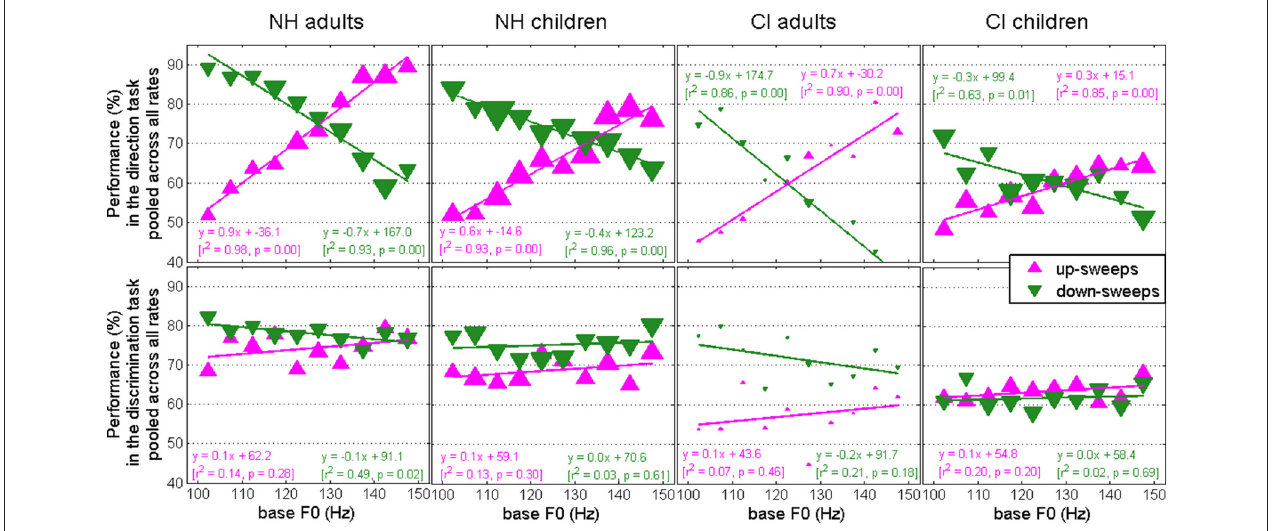
FIGURE 3 | Performance pooled across all rates and all subjects within a population, as a function of base F0, from which sweeps were constructed, which was roved between 100 and 150Hz. There was a large influence of base F0 for the direction task (top) , but none in the discrimination task (bottom) .